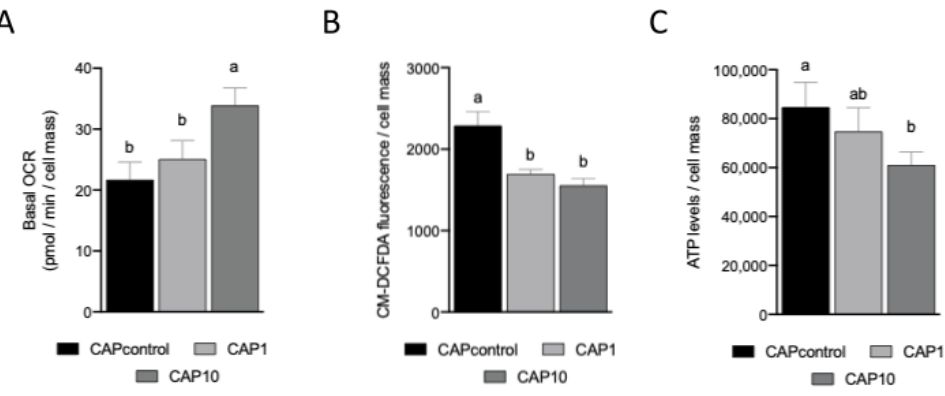
Figure 3. Effects of the mitochondria-targeted hydroxybenzoic acid derivative AntiOxBEN2 supple- mentation on mitochondrial oxygen consumption, ATP, and ROS levels of spermatozoa during the capacitation process. ( A ) The basal oxygen consumption rate (OCR) of bovine spermatozoa in the presence or absence of AntiOxBEN2 (1 and 10 µM) supplementation during the capacitation process was analyzed by using the Seahorse XFe96 Extracellular Flux Analyzer. Data are mean ± SEM of 16 replicates for each bull, and the results are expressed as pmol O2/min/cell mass. ( B ) The average fluorescence signal of the cellular CM-H2DCFDA oxidation product of bovine spermatozoa in the presence or absence of AntiOxBEN2 (1 and 10 µM) supplementation during the capacitation process. Data are mean ± SEM of 8 replicates, and the results are expressed as CM-H2DCFDA fluorescence per spermatozoa cell mass. ( C ) Intracellular ATP levels of bovine spermatozoa in the presence or absence of AntiOxBEN2 (1 and 10 µM) supplementation during the capacitation process. Data are mean ± SEM of 8 replicates, and the results are expressed as ATP levels per spermatozoa cell mass. Significant differences between the indicated conditions are marked by different letters (a ≠ b, p < 0.05); CAPcontrol: capacitation medium without supplementation; CAP1: capacitation me- dium supplemented with 1 µM of AntiOxBEN2; CAP10: capacitation medium supplemented with 10 µM of AntiOxBEN2.